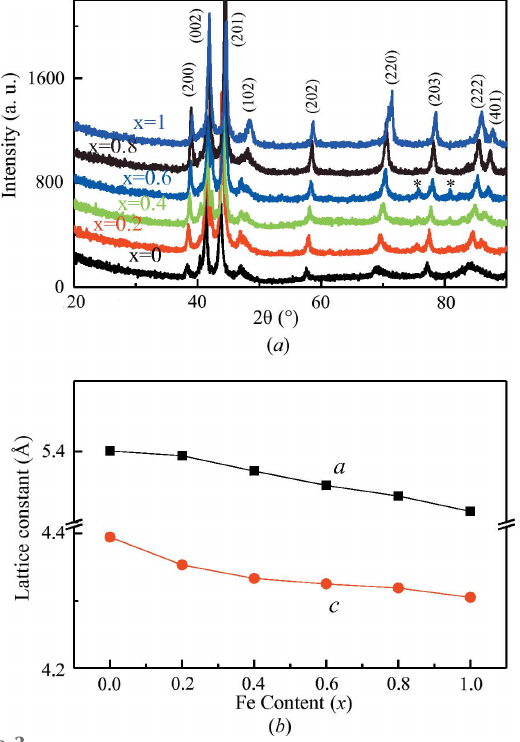
Figure 2 ( a ) XRD spectra measured at room temperature for Mn 3 (cid:2) x Fe x Ga samples heat treated at 623 K; ( b ) effects of Fe substitution with Mn on the lattice parameters.